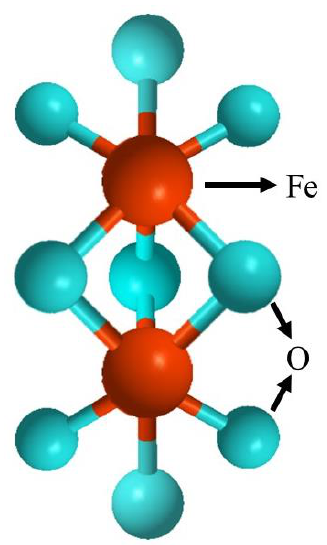
Figure 1. Struct ure of α -Fe 2 O 3